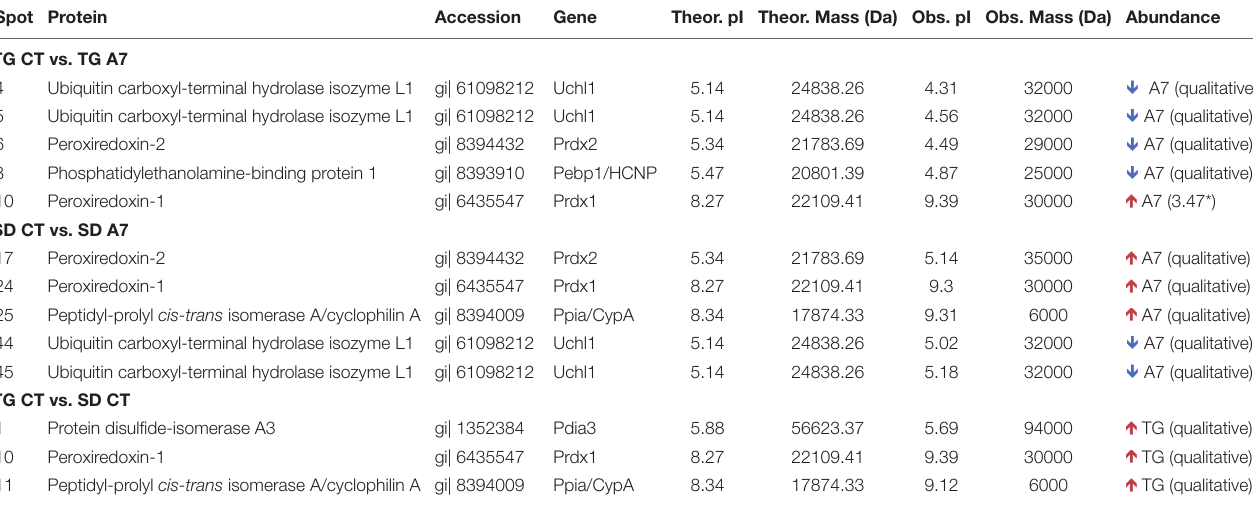
TABLE 2 | Identification of differentially expressed proteins in the hypothalamus of Sprague-Dawley (SD) and TGR (mRen2)27 (TG) rat treated with 14 days of Ang-(1–7) (A7) or saline ICV infusion the control group (CT). Spot Protein